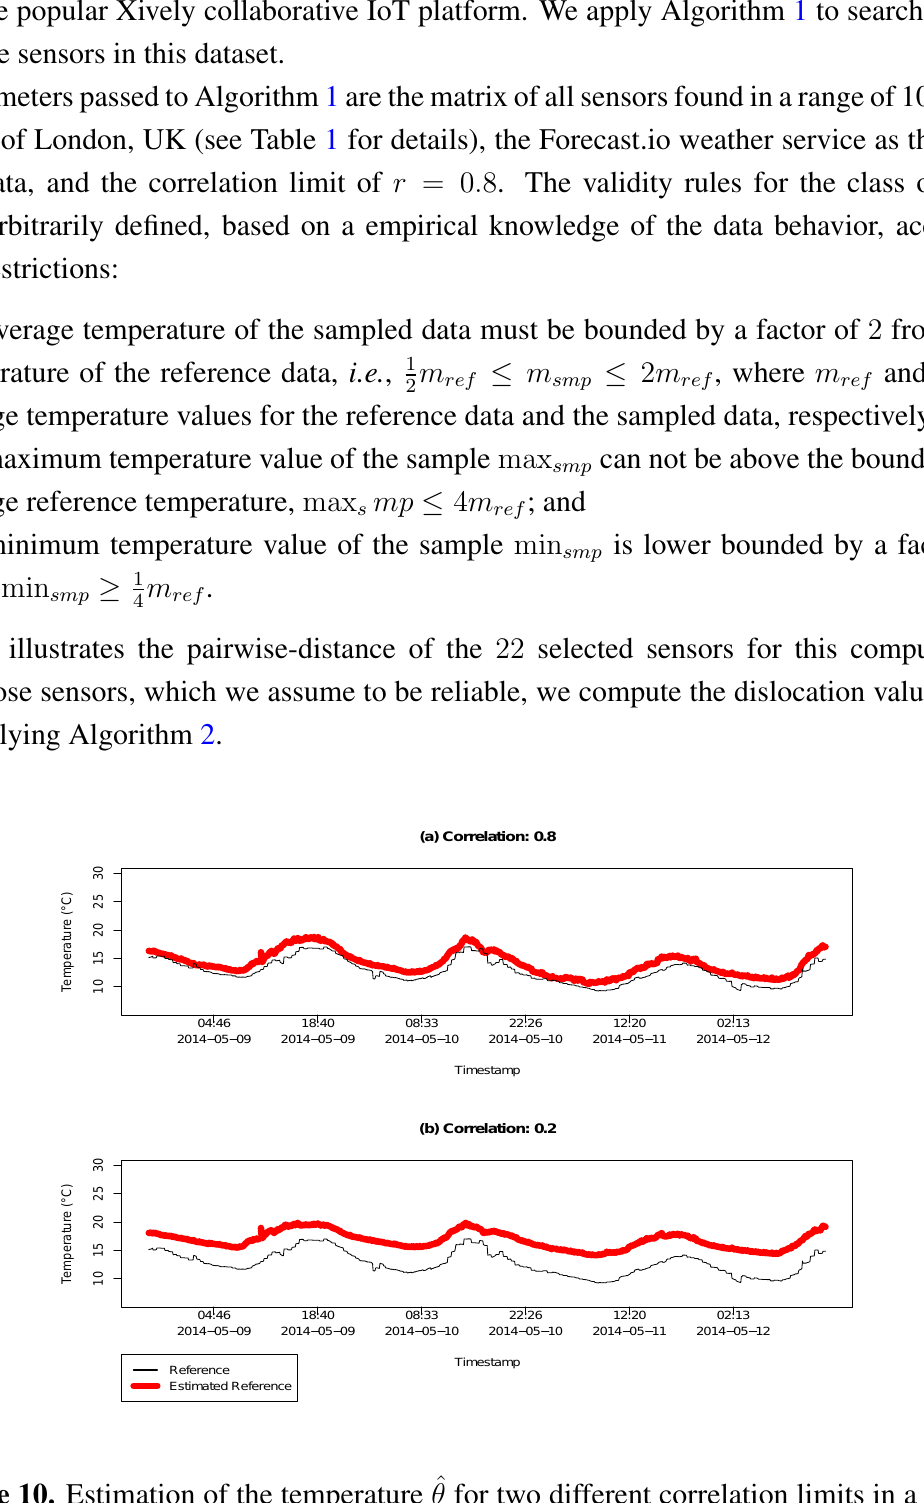
Figure 10. Estimation of the temperature ˆ θ for two different correlation limits in a range of 100 km from the coordinates of London, UK, in Dataset 1: ( a ) for sensors with correlation r ≥ 0 . 8 with MSE = 2 . 244199 ; and ( b ) for sensors with correlation r ≥ 0 . 2 with MSE = 16 . 85198